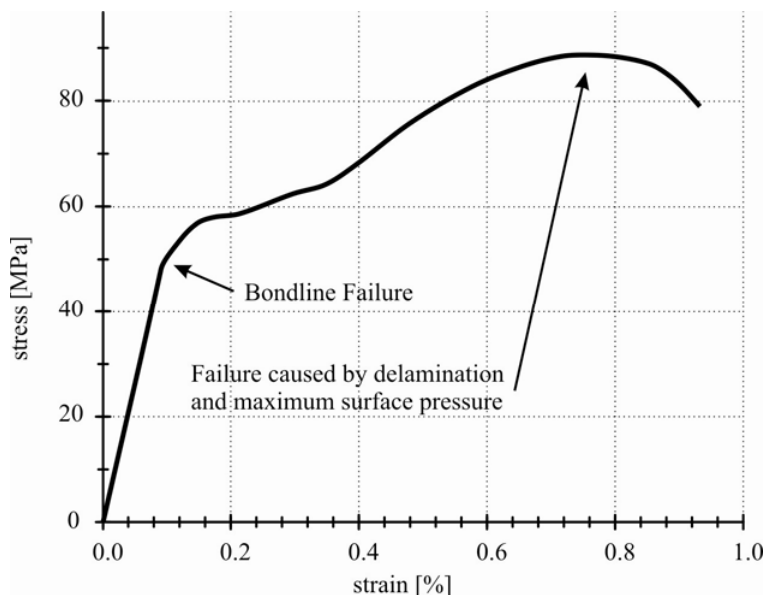
Figure 8. Typical failure shown in stress-strain diagram.